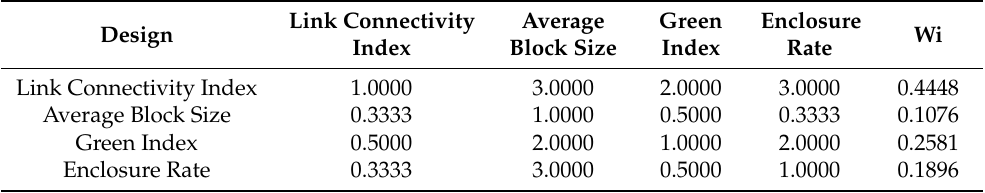
Table A11. Design Consistency ratio: 0.0618; Weight of “5D”: 0.2270; λ max: